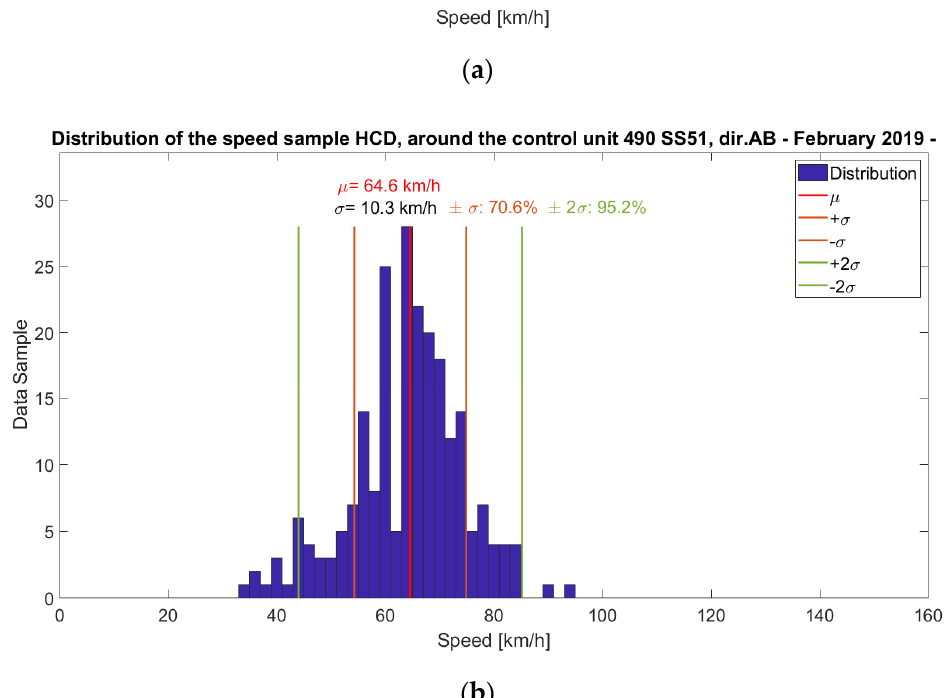
Figure 3. HCD speed samples’ distributions: ( a ) close to the control unit 1333, AB direction, August 2018; ( b ) close to the control unit 490, AB direction, February 2019.